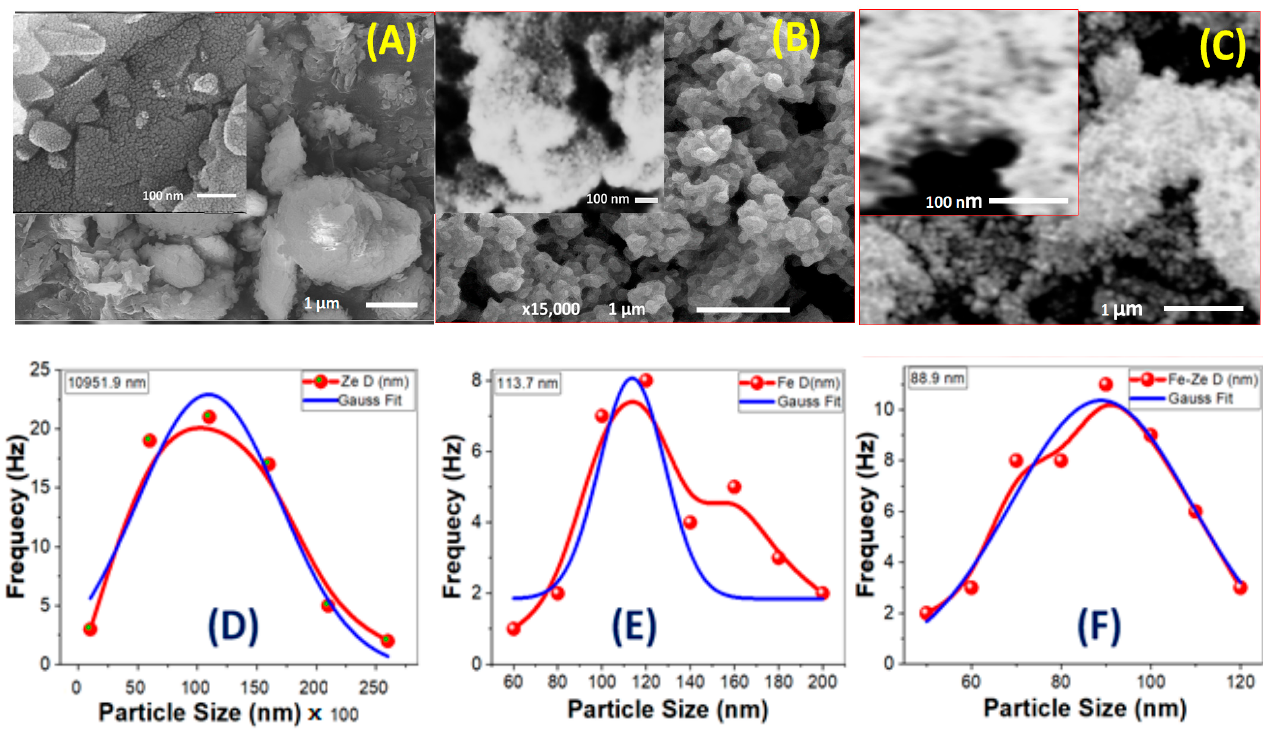
Figure 1. SEM micrographs and the corresponding particle size distribution for ( A , D ) natural zeolite, ( B , E ) Fe 2 O 3 , and ( C , F ) Fe 2 O 3 ‐ zeolite.